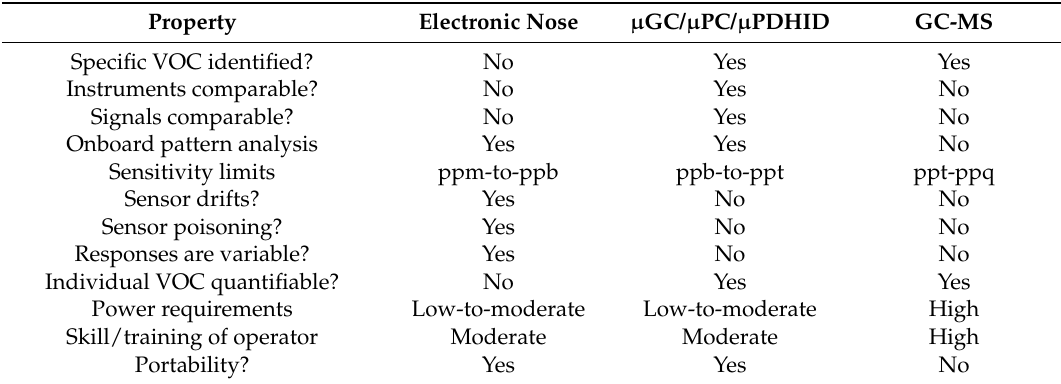
Table 3. Comparison of portable e-Nose and microsystems with